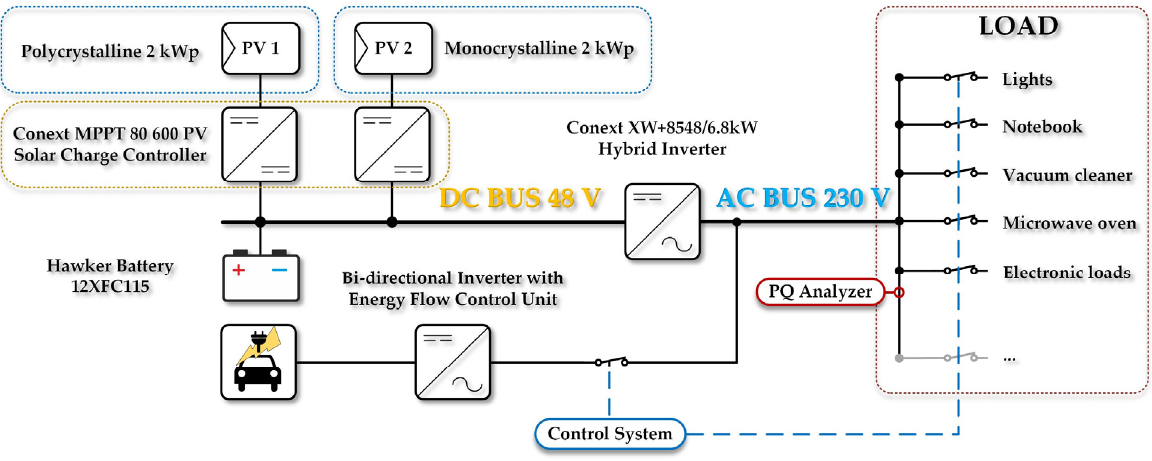
Figure 1. Diagram of the entire test platform [32].